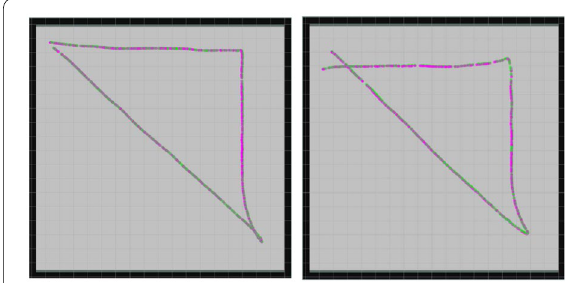
Fig. 12 Measured trajectories. Green lines indicate the trajectories obtained using the robotic total station, and blue lines indicate the trajectories obtained using the RTK-GPS (left figure) and QZSS (right figure)